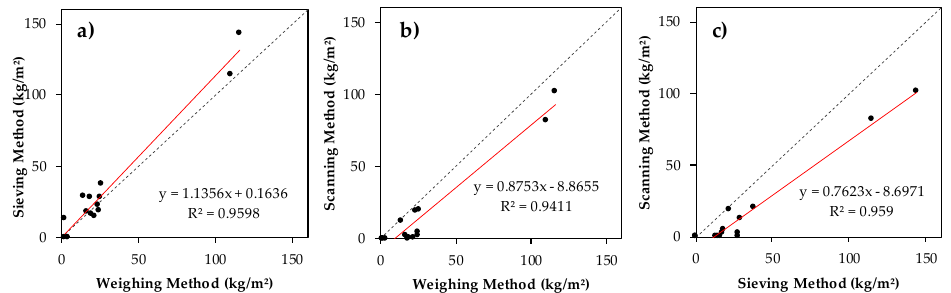
Figure 6. Soil mass loss results in the following comparison: ( a ) sieving versus weighing, ( b ) scanning versus weighing, and ( c ) scanning versus sieving.